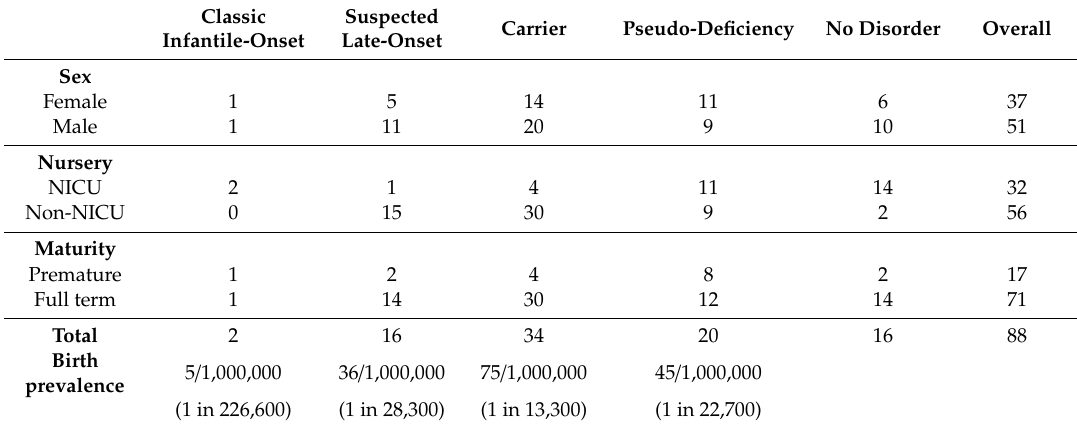
Table 2. California Pompe disease screening results (among screen positives) by neonatal factors.